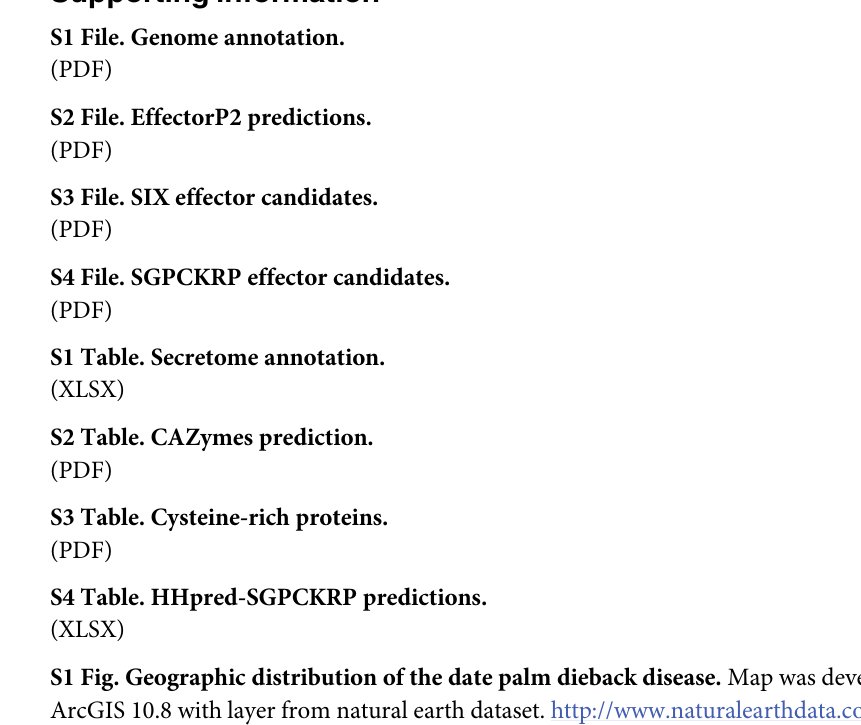
S1 Fig. Geographic distribution of the date palm dieback disease. Map was developed using ArcGIS 10.8 with layer from natural earth dataset.